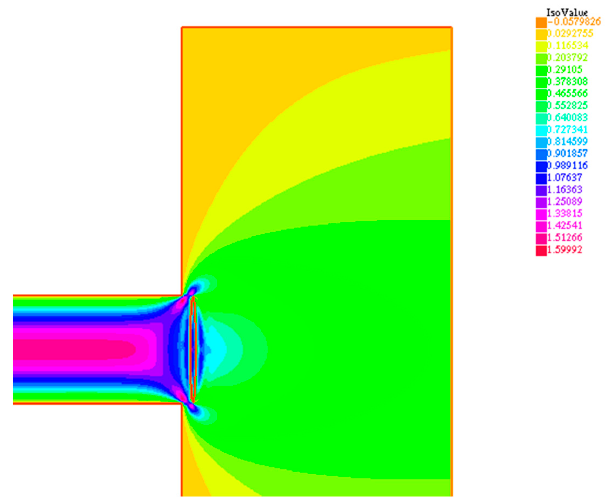
Figure 5. Case 1: valve operative condition with h = 3 m, with velocity horizontal component u .